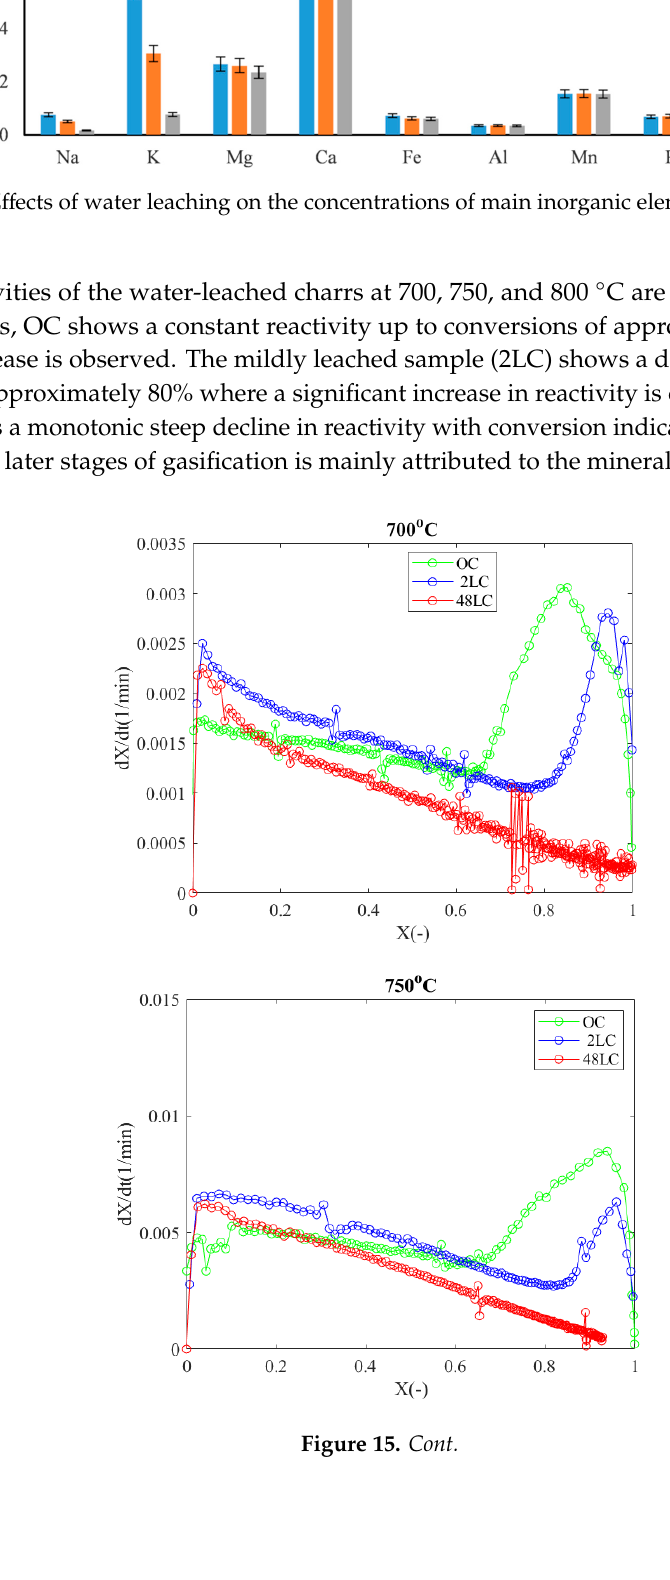
Figure 15. Gasification rate versus conversion for OC, 2LC, and 48LC at different temperatures.